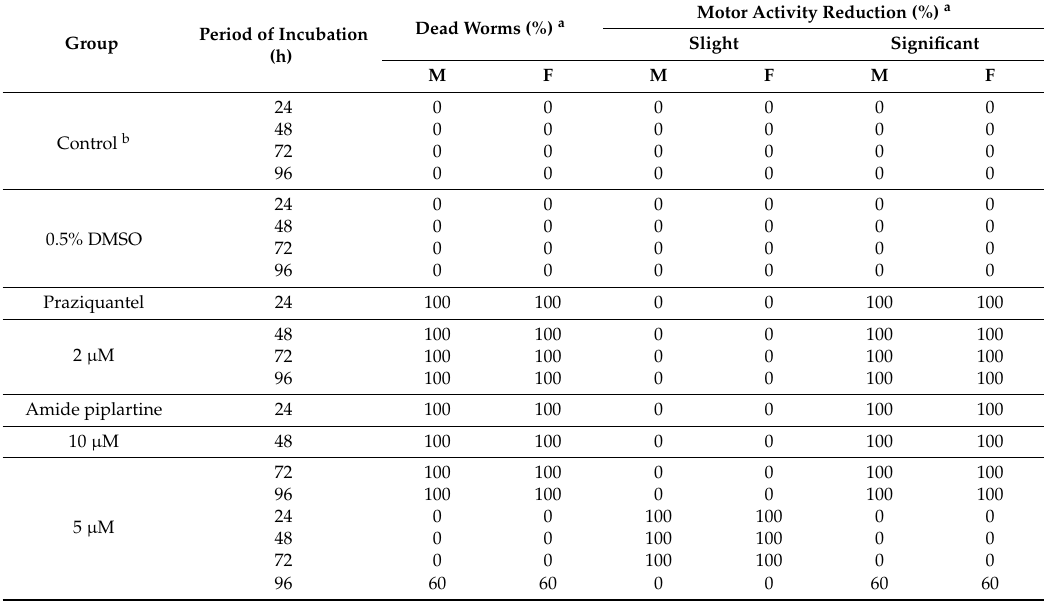
Table 4. In vitro effects of compounds in 49-day-old S. mansoni